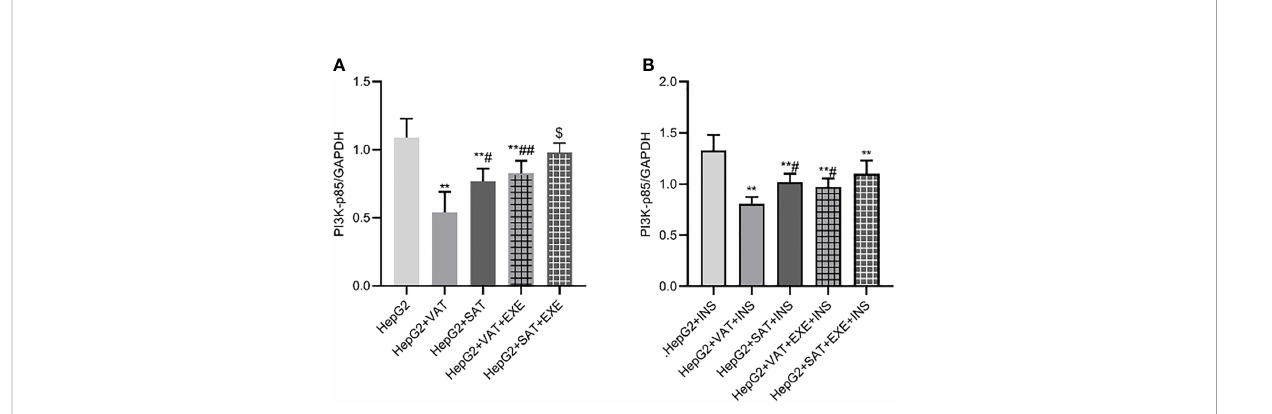
FIGURE 7 The in fl uence of exenatide on the expression of PI3K-p85 protein in hepatocytes conducted by different regional adipose tissue. (A) Expression of PI3K-p85 protein in HepG2 cells of each group. Data are means ± SEM, n = 3/group, **P < 0.01 vs. HepG2 group; # P < 0.05, ## P < 0.01 vs. HepG2+VAT group; $ P < 0.05 vs. HepG2+SAT group. (B) Expression of PI3K-p85protein in HepG2 cells of each group under the action of insulin. Data are means ± SEM, n = 3/group, **P < 0.01 vs. HepG2+INS group; # P < 0.05 vs. HepG2+VAT+INS